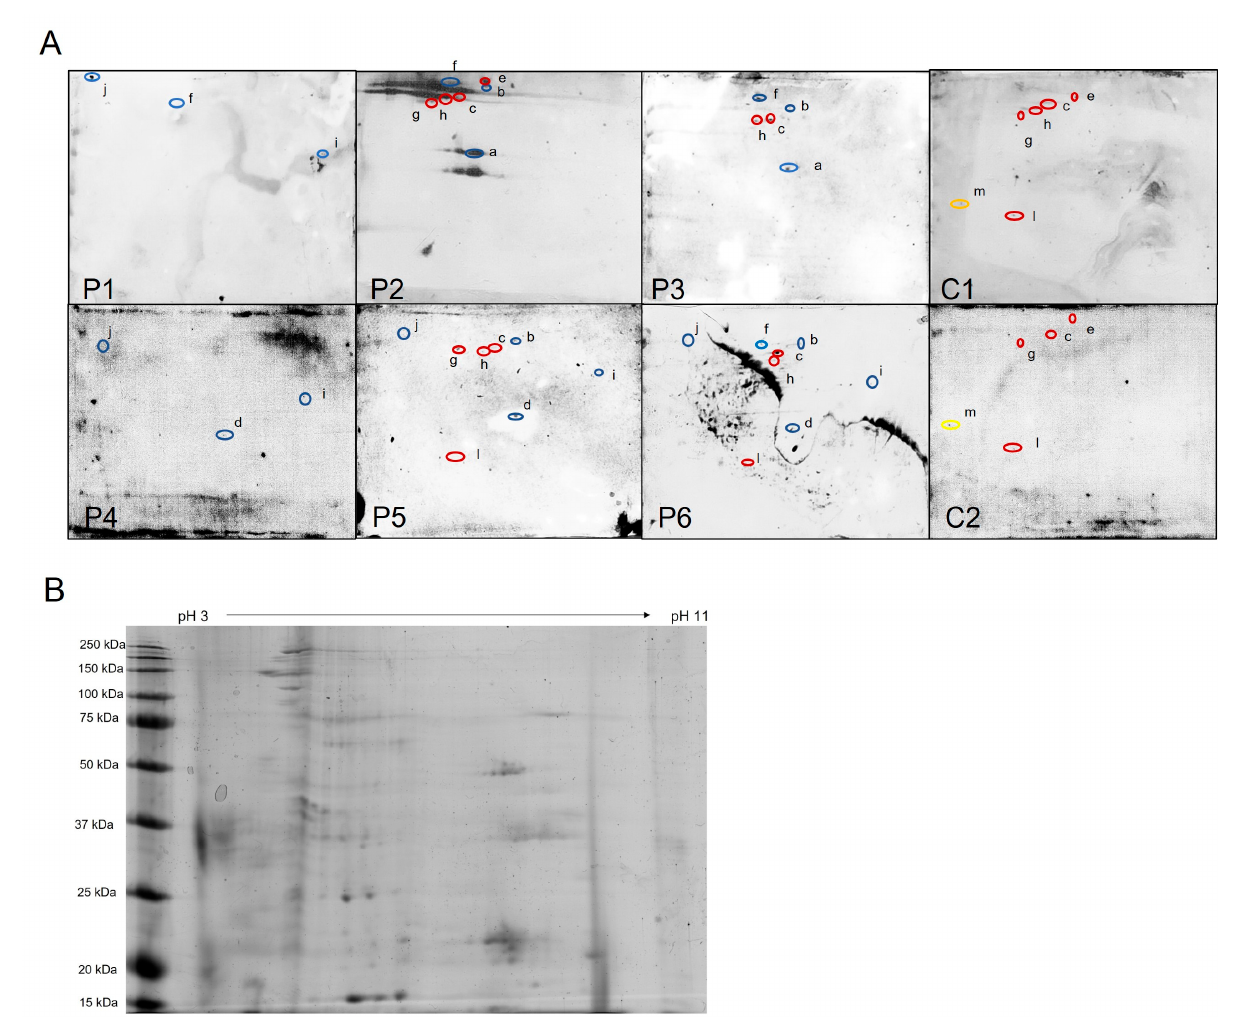
Figure 1. Identification of HNE-modified proteins from erythrocyte membrane of HH patients. ( A ) Western blots of HH patients (P1–P6) and healthy controls (C1 and C2). Protein spots identified by MALDI-TOF-TOF are designated with “a–m” letters and encircled with colours: red are spots present in patients and controls; blue spots are present only in HH patients; and yellow spots are only in controls. ( B ) Representative two-dimensional Coomassie brilliant blue-stained gel with total erythrocyte membrane proteins (Control sample 1). 4-hydroxynonenal (HNE), Hereditary hemochromatosis (HH).